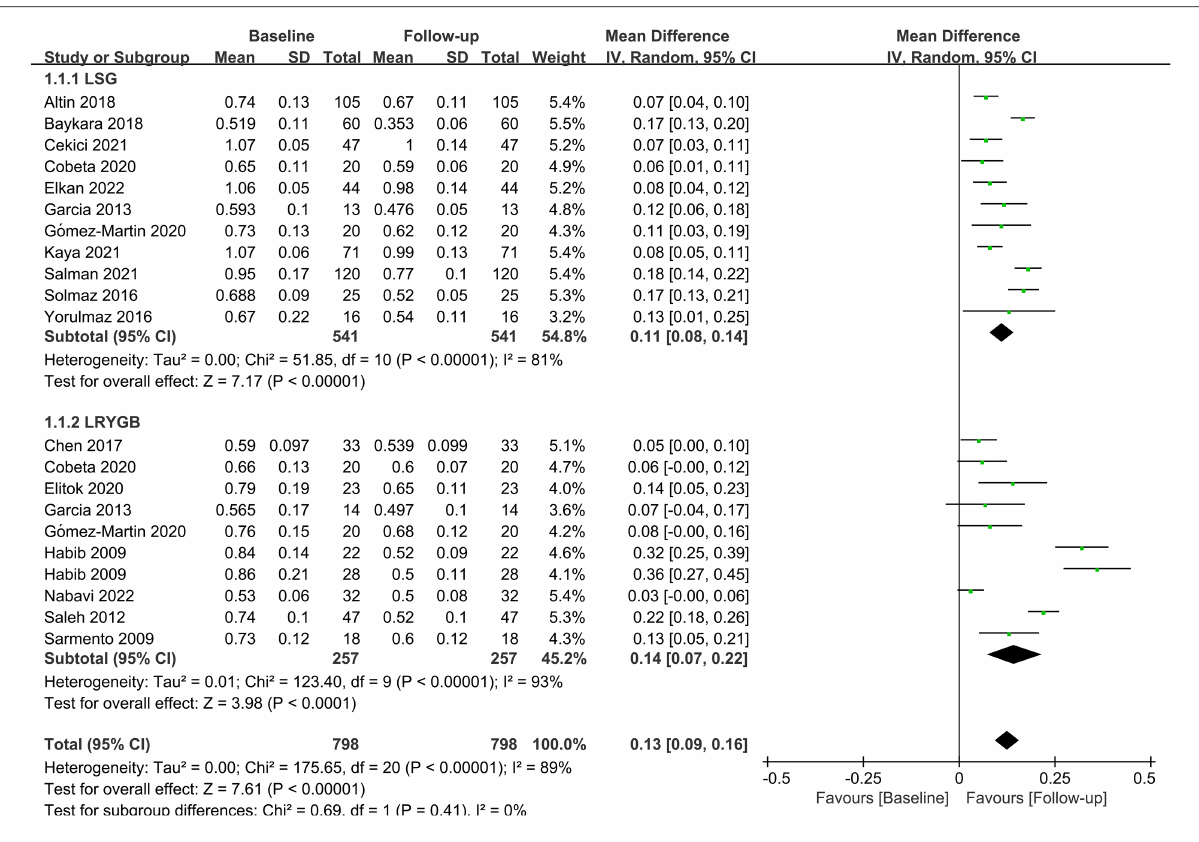
FIGURE 5 Forest plot of meta-analysis for CIMT by the type of surgery. (Cobeta 2020, Garcia 2013, Habib 2009, Gómez-Martin 2020 respectively included two subsets of data for meta-analysis).